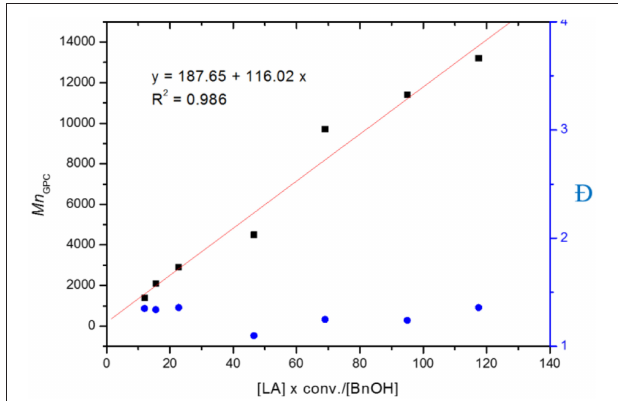
FIGURE 4 | Linear plot of Mn GPC vs. [LA] × conv. / [BnOH], with Ðindicated by blue dots (entries 1–7 in Table 2 ).